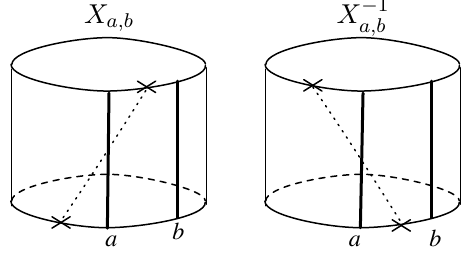
Figure 22 . X a;b and its inverse tracks the change of the base points.